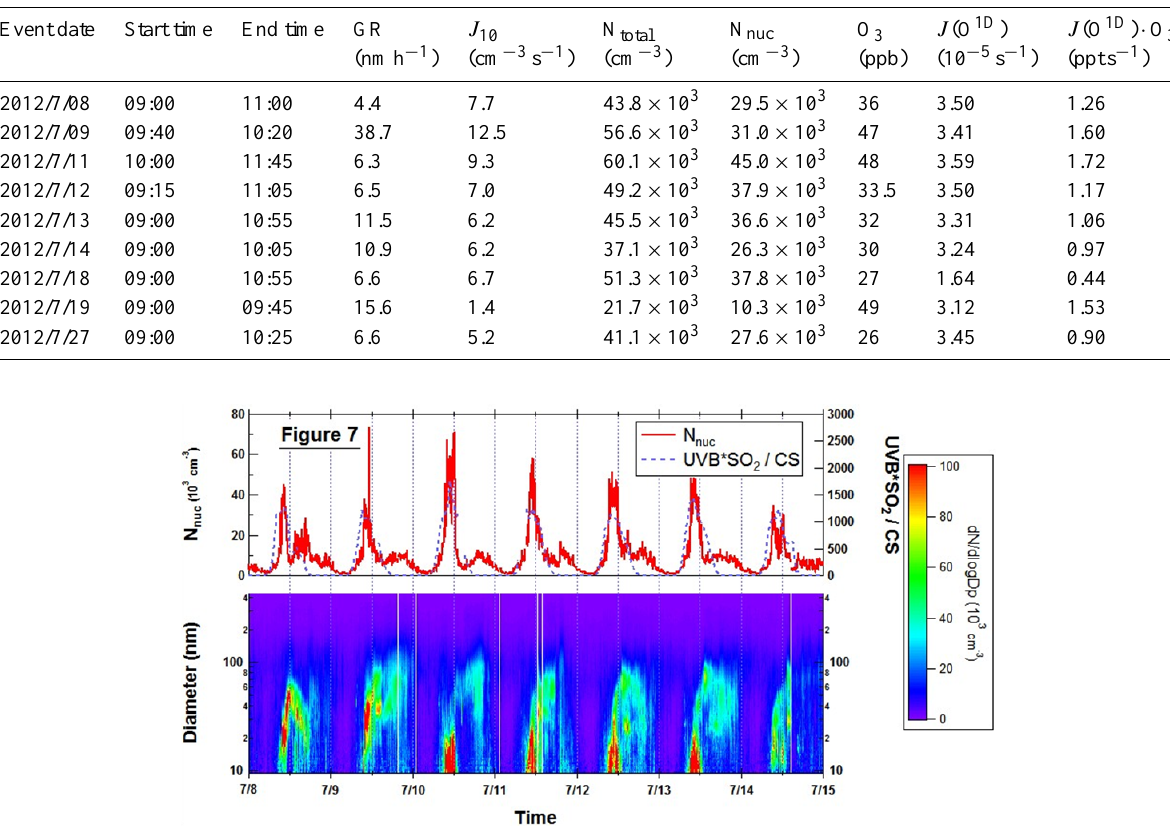
Fig. 7. Time series of particle size distribution (lower panel) and number concentration of nucleation mode ( N nuc ) and UVB · SO 2 /CS (upper panel) for 8–14 July